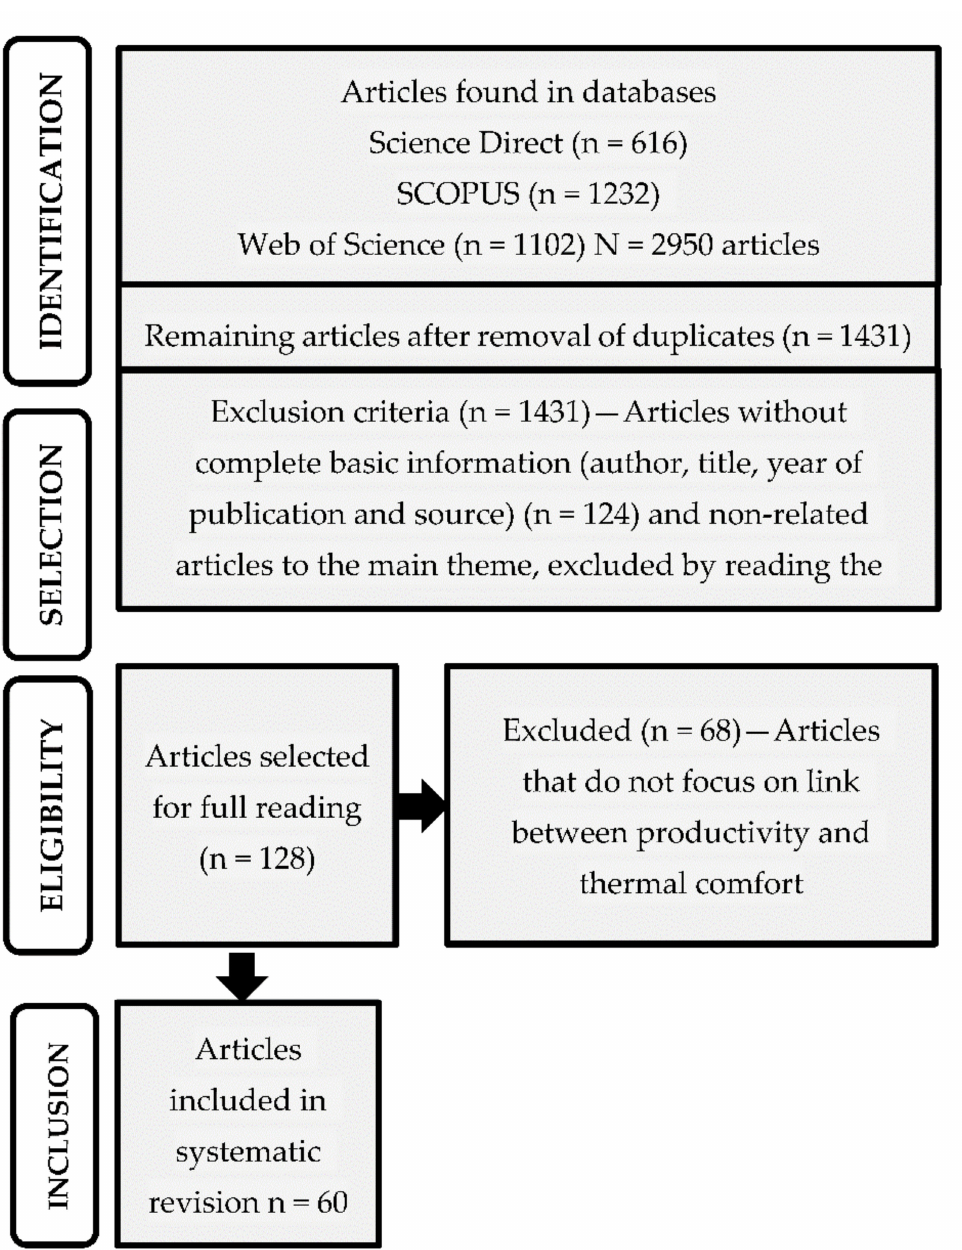
Figure 1. Results after applying the PRISMA